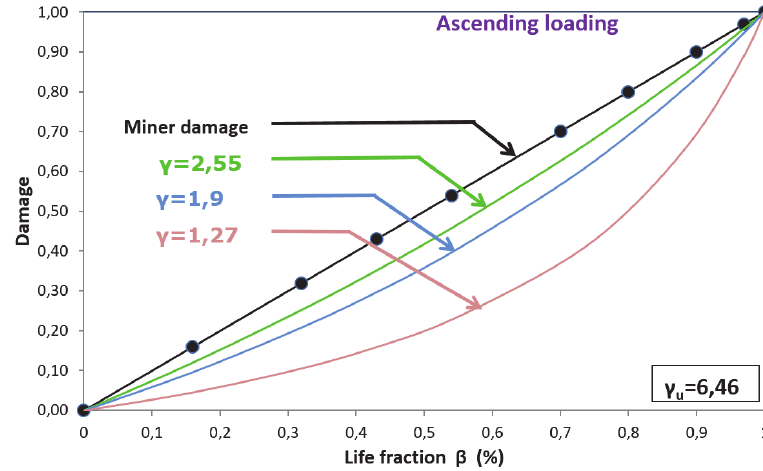
Figure 7: Unified theory damage variation in function of the life fraction β .